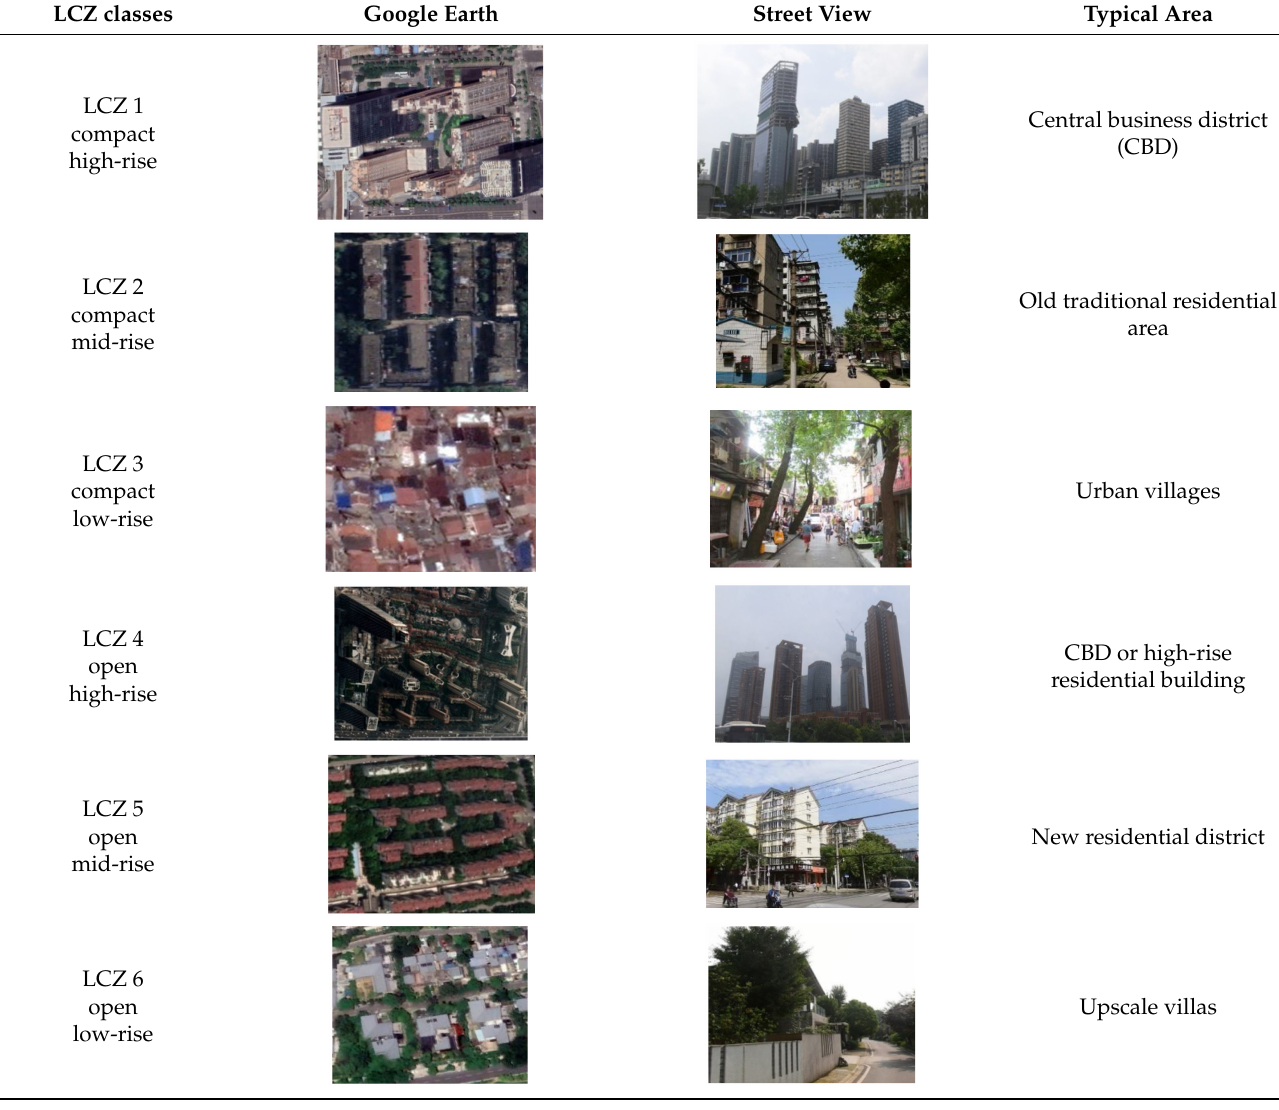
Table 4. Google Earth and Street View photo of built-up LCZ classes (1–6) and typical